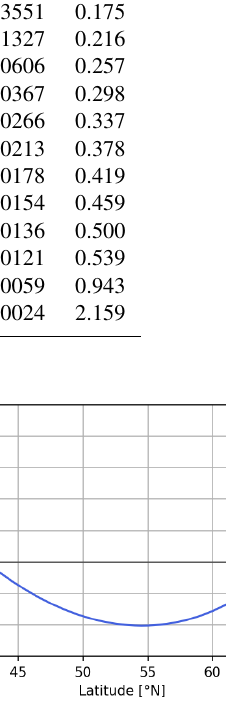
Figure 11. The effective scale of a Lambert conformal conic map in dependency of the latitude if the scale at 42.5 and 65.5 ◦ N is set to 1.0. The minimum scale of 0.98 is reached at a latitude of 54.5 ◦